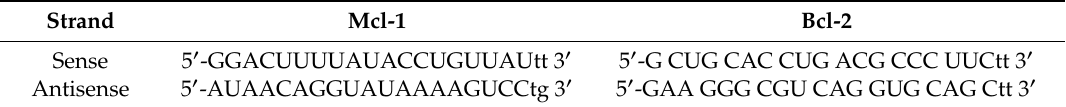
Table 1. Sense and antisense sequences of two pro-apoptotic siRNAs (Mcl-1 and Bcl-2). Strand